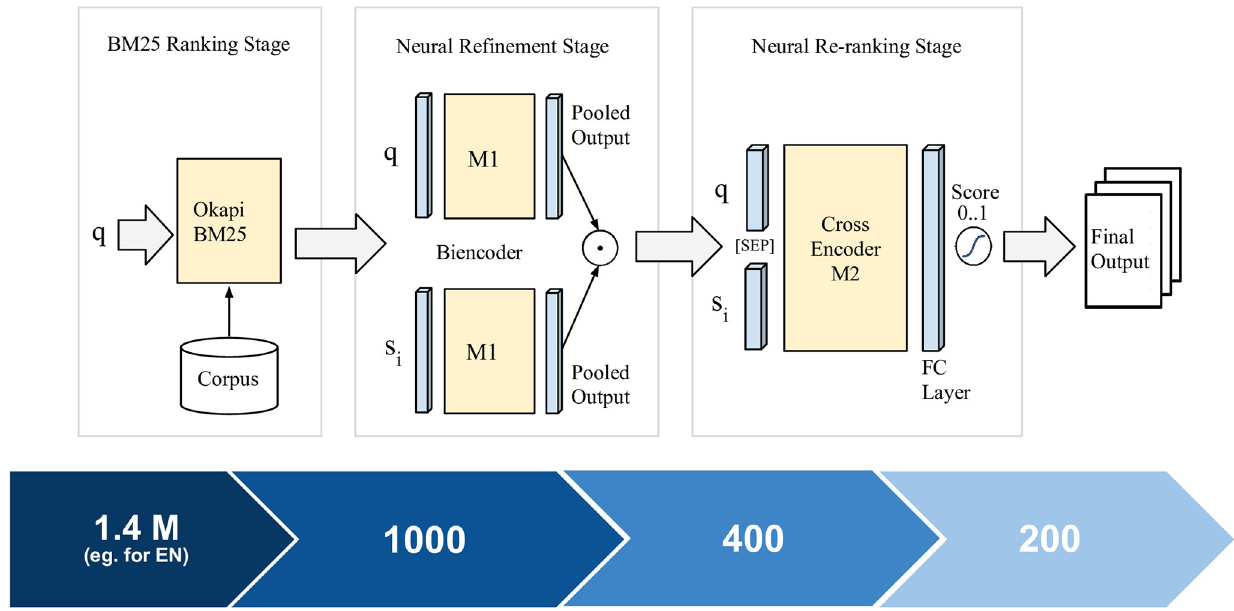
Fig 1. Overview of Multistage BiCross encoder. The blue bar below shows top k candidate documents ranked in each